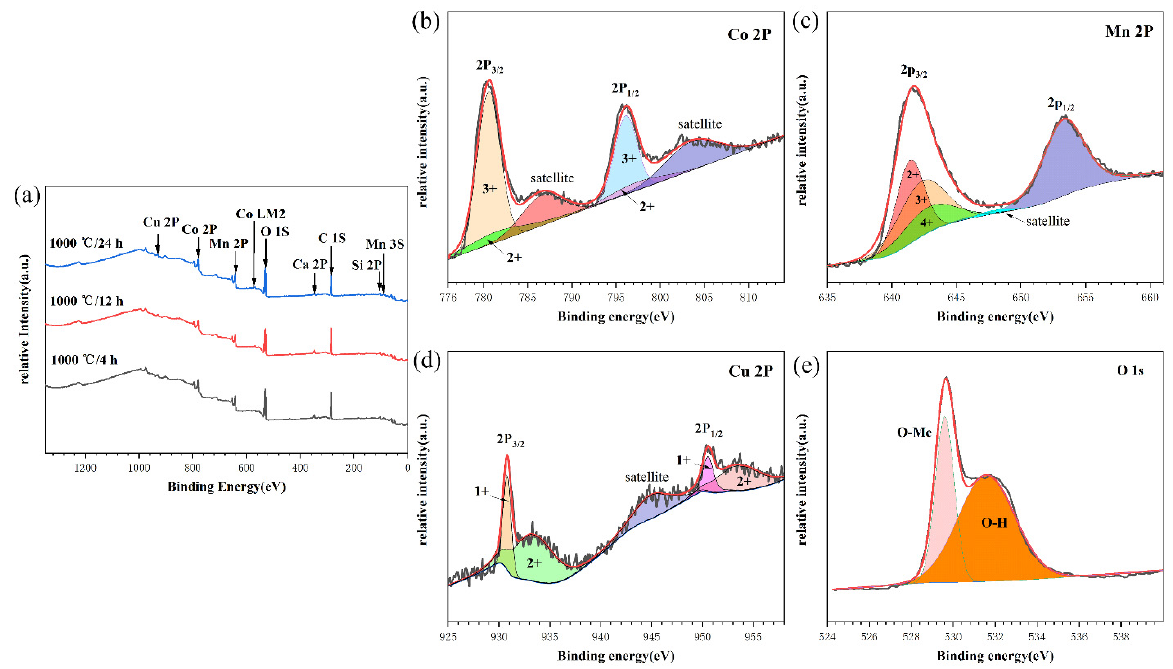
Figure 9. XPS spectra of Cu 0.3 Mn 1.5 − x Co 1.5 − y O 4 powders sintered at 1000 ◦ C: ( a ) survey; ( b ) Co 2P of 1000 ◦ C/12 h sample; ( c ) Mn 2P of 1000 ◦ C/12 h sample; ( d ) Cu 2P of 1000 ◦ C/12 h sample; ( e ) O 1s of 1000 ◦ C/12 h sample. Table 3. Areal fractions of Mn and Co in the powders prepared under different conditions.